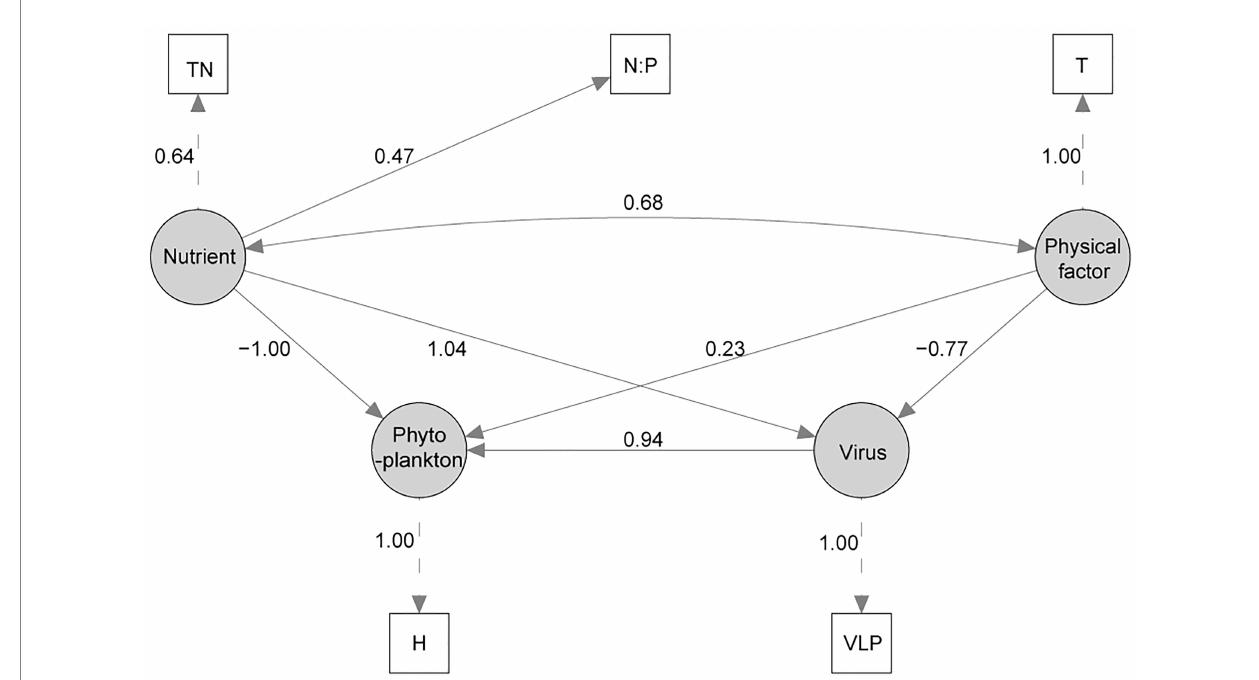
FIGURE 5 The structural equation model (SEM) of the effects of virus, nutrient, and physical variable on phytoplankton community. Measured variables are indicated with rectangles, latent (unmeasured) variables with ovals. Numbers beside each arrow indicate the standardized path coefficient. (TN, total nitrogen; N:P, TN/TP ratio; T , water temperature; VLP, viral-induced lysis rate of phytoplankton; H, Shannon Wiener